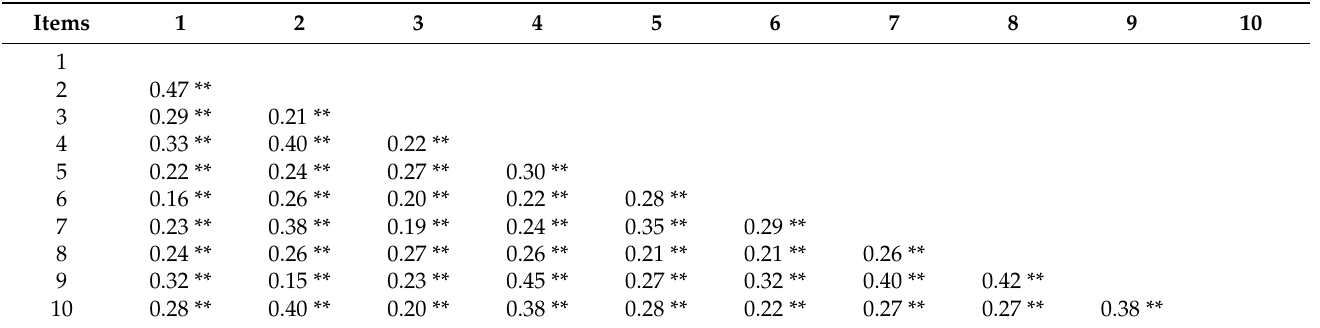
Table 4. Correlations between the different items.